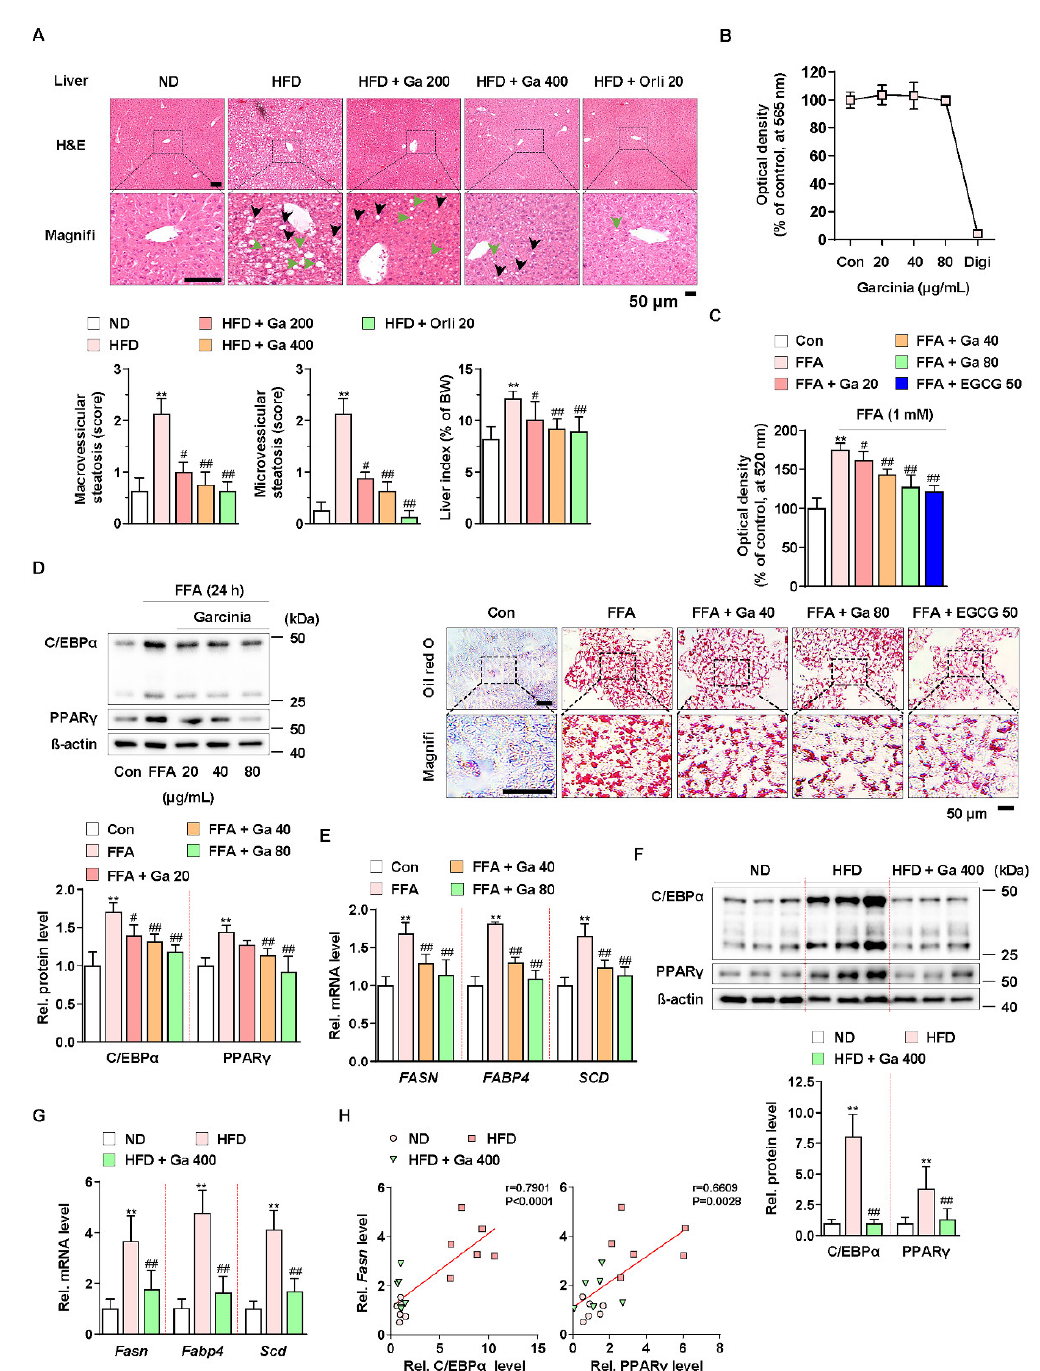
Figure 1. Anti-NALFD effect of Garcinia cambogia in HFD-fed mice reducing hepatic steatosis. ( A ) Representative images showing the effect of G. cambogia (Ga, 200 and 400 mg/kg) on HFD-induced hepatic steatosis. H&E staining of liver tissues was performed. The scores of macrovesicular (black arrow) and microvesicular (green arrow) steatosis and liver index were quantified, as described in the Methods section. Normal diet (ND)-fed mice were used as the negative control for high levels of fat accumulation, and orlistat (20 mg/kg) was used as the positive control for anti-obesity and anti-steatosis effects ( n = 7 per group). Scale bars: 50 μm. Magnifi: magnification. ** p < 0.01 vs. ND-fed mice, # p < 0.05 and ## p < 0.01 vs. HFD-fed mice. ( B ) MTT assay showing the effect of G. cambogia (20–80 μg/mL) on cell viability. HepG2 cells were treated with the indicated concentration of G. cambogia and digitonin (100 μg/mL, positive control) for 24 h ( n = 5 per group). ( C ) oil red O assay and representative images showing the effect of G. cambogia (20–80 μg/mL) on free fatty acid (1 mM FFA)- induced lipid accumulation in HepG2 cells. FFA-induced HepG2 cells were treated with G. cambogia and EGCG (50 μM, positive control) for 24 h ( n = 5 per group). Scale bar: 50 μm. Magnifi: magnification. ** p < 0.01 vs. Con, # p < 0.05 and ## p <